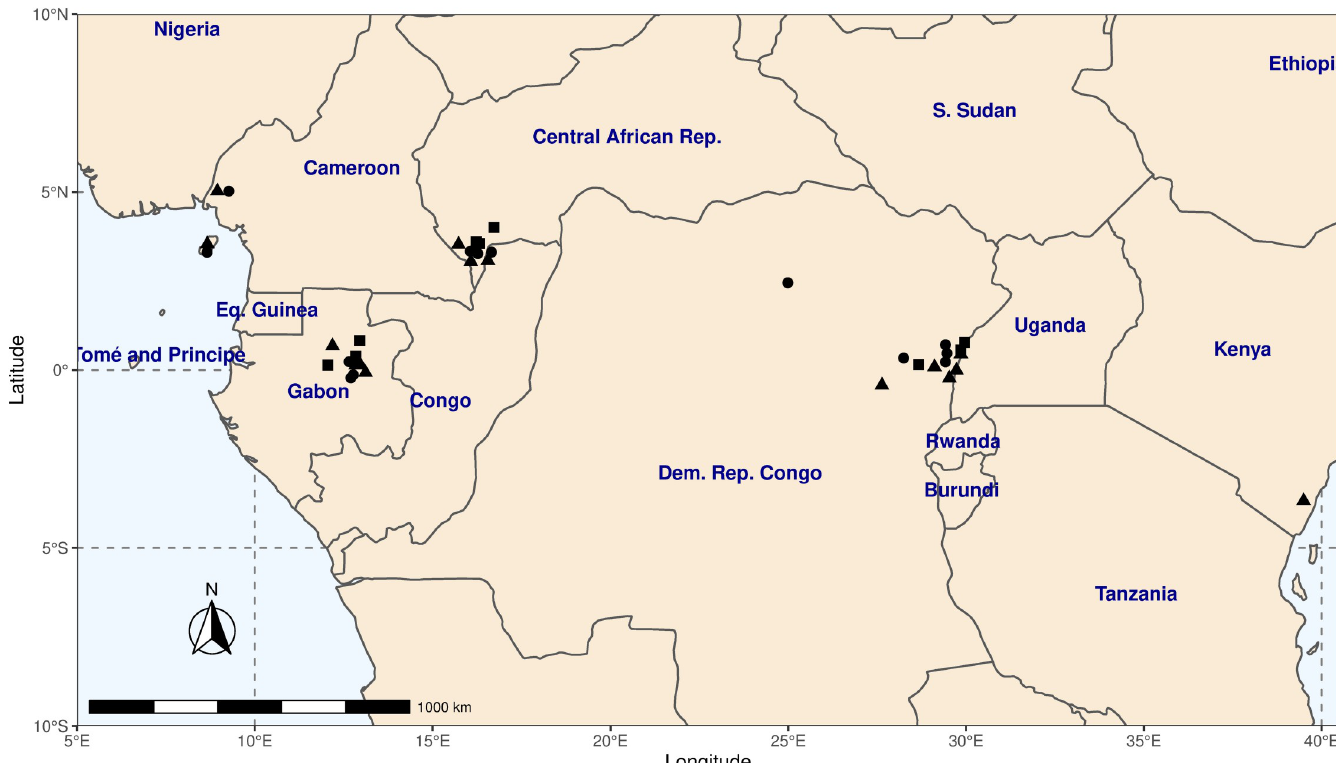
Fig 2. Geographic locations of field studies included in the duiker dataset. Studies comprised of Peters’ duiker C . callipygus (squares), bay duiker C . dorsalis (circles) and blue duiker C . monticola (triangles). Made with Natural Earth. Free vector and raster map data @ naturalearthdata.com.